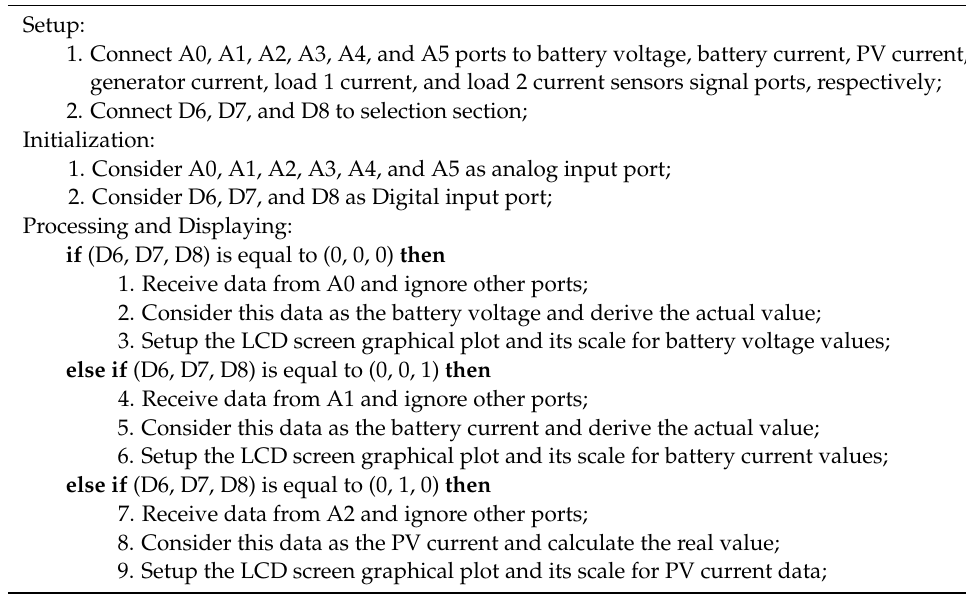
Algorithm 2: Wio terminal programming and